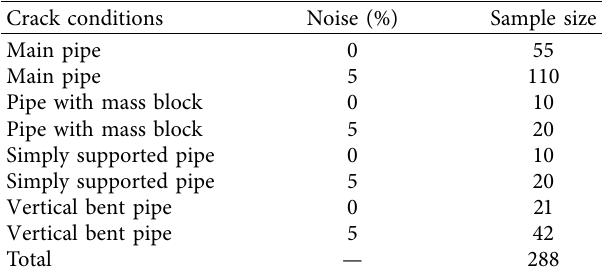
Table 6: Simulation of pipeline crack